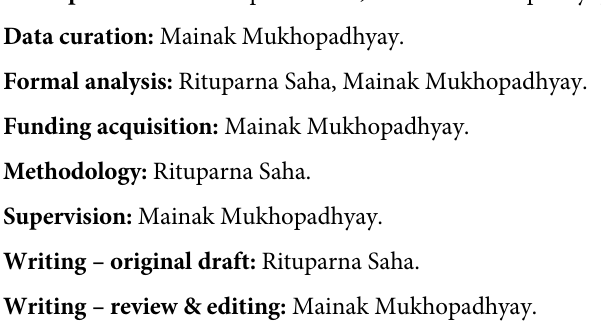
S2 Fig. Cyclic voltammograms of VA (2mM) with the mediator ABTS (0.1-1mM) in a buff- ered solution of pH 5 recorded at a scan rate of 100mV/s. (TIF) S3 Fig. Cyclic voltammograms of AL (0.05-2mM) in a buffered solution of pH 5 recorded at a scan rate of 100mV/s. (TIF) S4 Fig. Cyclic voltammograms of AL (0.2mM) with the mediator ABTS (0.1-1mM) in a buffered solution of pH 5 recorded at a scan rate of 100mV/s. (TIF) S5 Fig. Cyclic voltammograms of Guaiacol (0.1–10 mM) in a buffered solution of pH 5 recorded at a scan rate of 100 mV/s. (TIF) S6 Fig. Cyclic voltammograms of Guaiacol (2 mM) with the mediator ABTS (0.1–1 mM) in a buffered solution of pH 5 recorded at a scan rate of 100 mV/s. (TIF) S7 Fig. Cyclic voltammograms of Guaiacol (2 mM) with the mediator ABTS (0.5 mM) over 12 hours recorded in a buffered solution of pH 5 at a scan rate of 100 mV/s. (TIF) S8 Fig. Cyclic voltammograms of Guaiacol (2 mM) with Trametes versicolor laccase and the mediator ABTS (0.5 mM) over 12 hours recorded in a buffered solution of pH 5 at a scan rate of 100 mV/s. (TIF) S1 File. Cyclic voltammetry of Guaiacol with laccase/ABTS